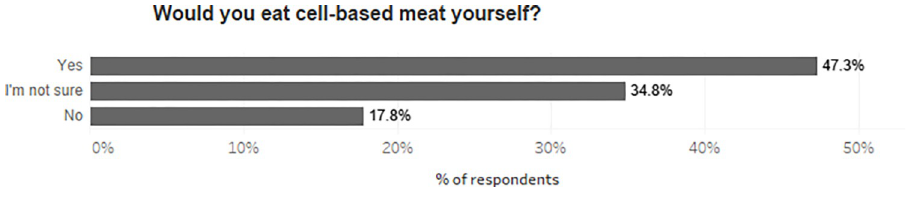
Fig 4. Willingness to feed cultivated